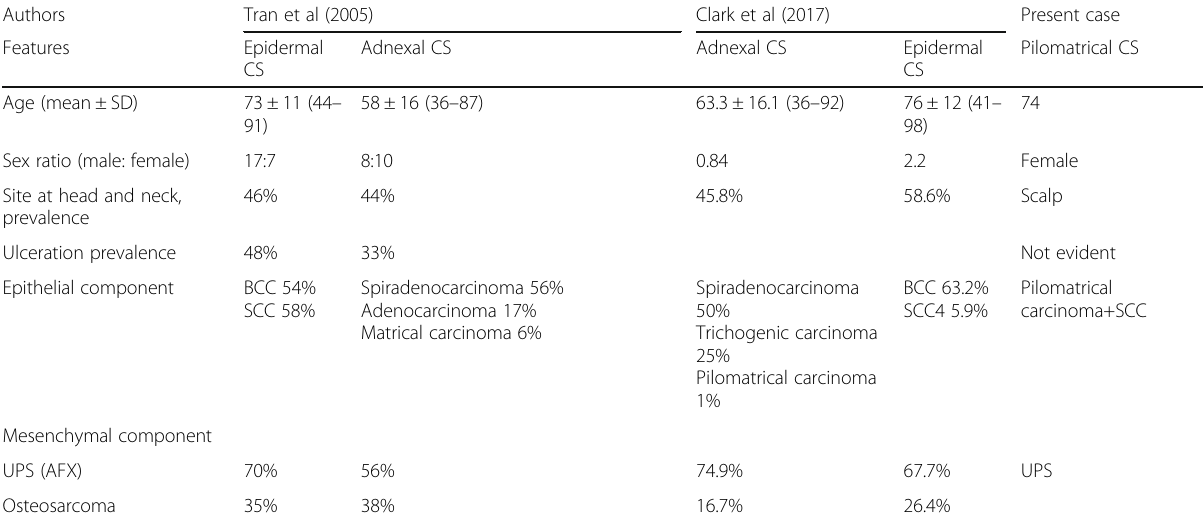
Table 4 Comparison of the present case and other reported cases of cutaneous carcinosarcoma